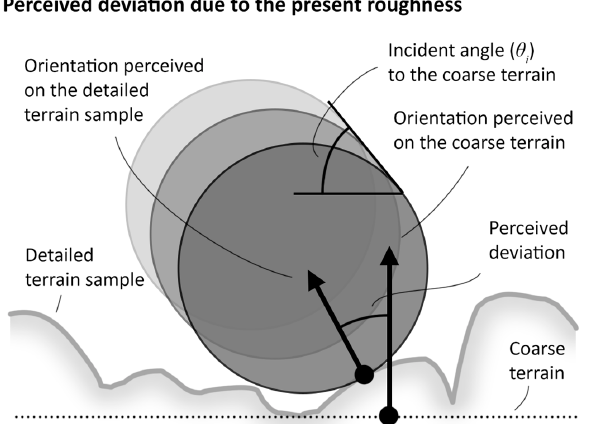
Figure 10. Measurement of the perceived deviation on the difference of DTM (DoD), represented here by the layer “Detailed terrain sample” combined with a flat “Coarse terrain”. The perceived deviation varies depending on the applied incident angle because some part of the terrain cannot be reached at shallow impact angles. In this 2D representation, the deviation measured is called vertical deviation. The lateral deviation is measured in the vertical plane perpendicular to the vertical profile of this figure (deviating toward the reader, or the opposite). The terrain samples should correspond to the highly detailed terrain elevation to which the coarse elevation of the DTM is subtracted (Difference of DTM–DoD) (Figure 11). The terrain should be oriented with its original slope aspect facing south because the simulated impacts extend from north to south, which ensures that the roughness facing upslope is measured for the different incident angles. The results are output as a distribu- tion of the vertical and lateral deviation angles perceived by the impacting rock compared to the terrain orientation it would perceive if the terrain were exempt of any roughness.